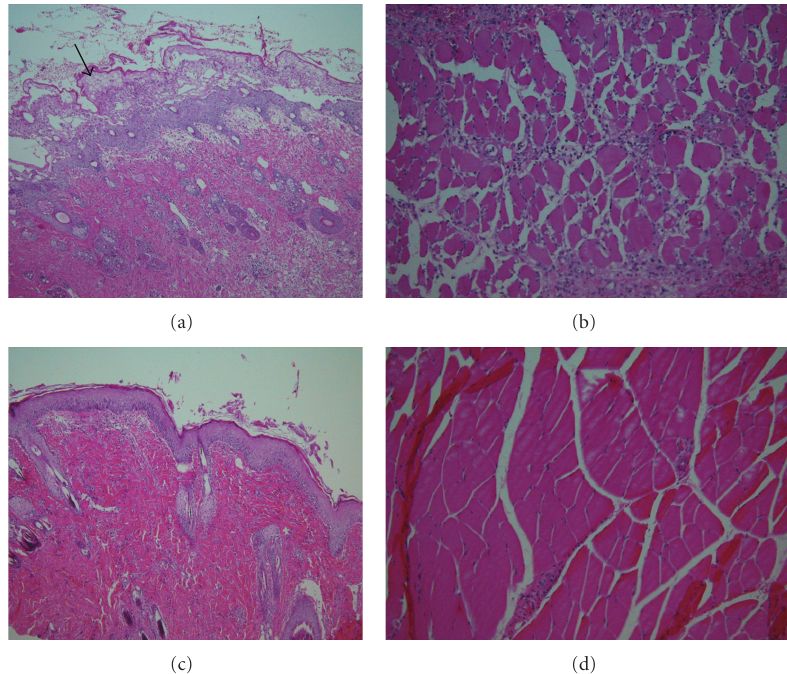
Figure 7: Photomicrographs (original mag: 200 × ) of Day +7 VCA-Skin ((a) and (c)) and VCA-Muscle ((b) and (d)) biopsies from SHAM/VCA ((a) and (b)) and TREATED/VCA ((c) and (d))